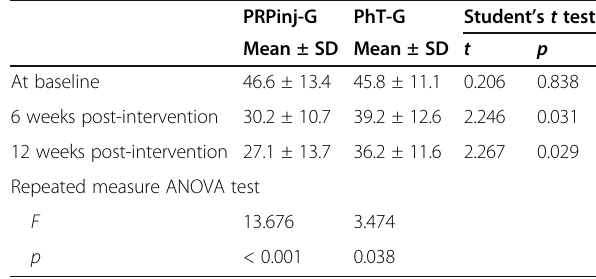
Table 3 Comparison of the DASH score between the PRPinj-G and PhT-G at baseline and after 6 and 12 weeks post-